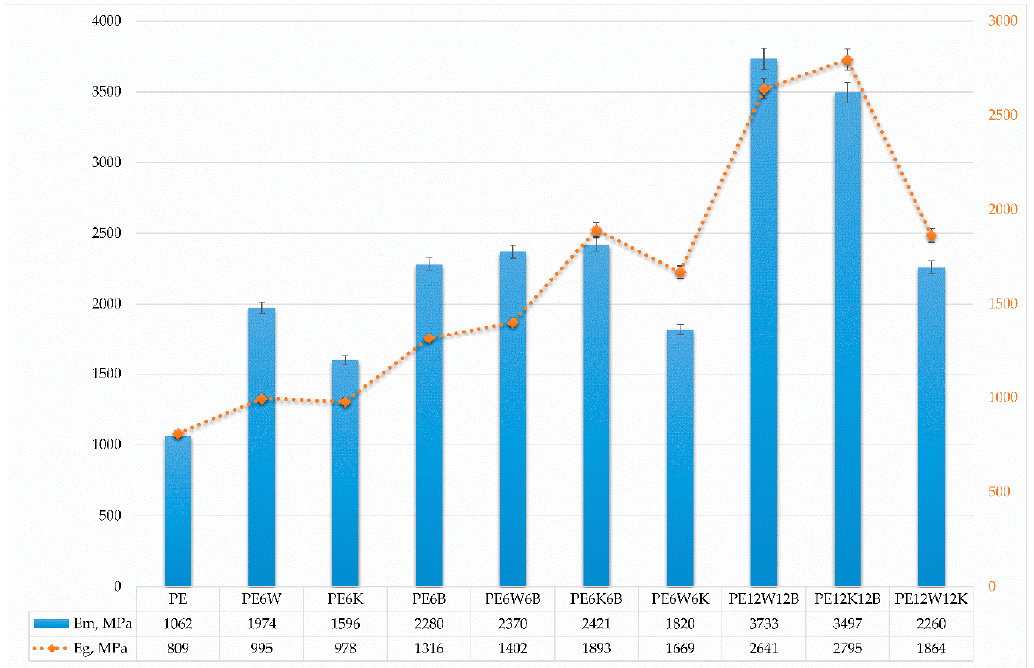
Figure 2. Comparison of tensile (Em) and flexural (Eg) modulus of tested materials.